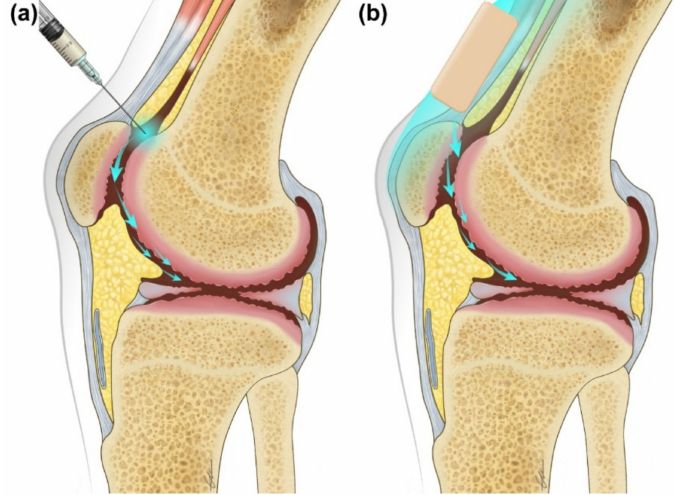
Figure 1. ( a ) Intra-articular injection of opioids in the painful knee joint of knee osteoarthritis patients, ( b ) application of the buprenorphine transdermal patch on the painful knee joint of knee osteoarthritis patients (Jong’s